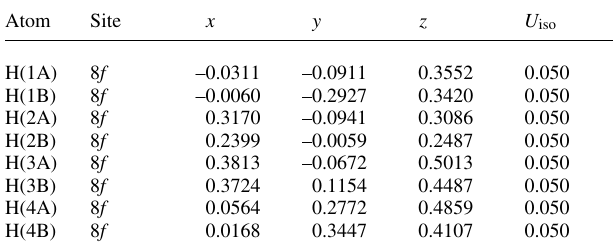
Table 4. Data collection and handling.